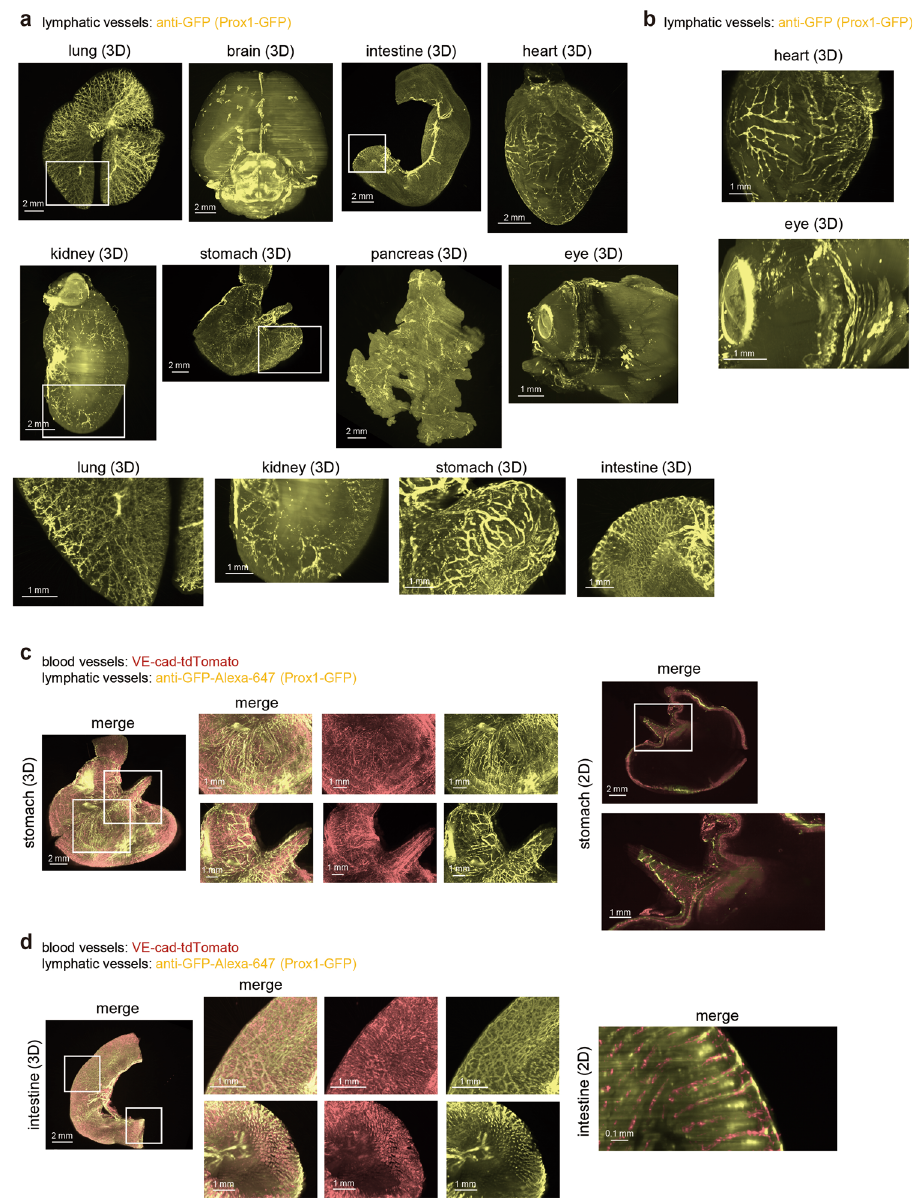
Fig. 2 | Whole-organ 3D imaging of mouse lymphatic vessels. a The 3D whole- organimagesofmouselymphaticvesselsinthelung,brain,intestine,heart,kidney, stomach, pancreas, and eye. Prox1-GFP mice (2-4 months) were sacri fi ced and subjected to CUBIC procedures as shown in Fig. 1a. To enhance the signals from Prox1-GFP, samples were stained with anti-GFP antibody ( Z = 10 μ m step, digital zoom; lung,brain, stomach, and pancreas1.25, intestine and kidney: 1.6, heart: 2.0, eye: 4.0). The enlarged 3D images (white insets) are shown in the bottom. b The